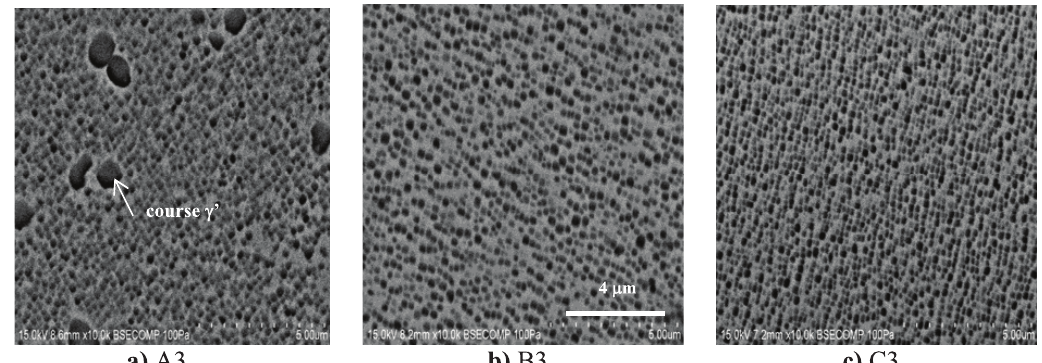
Figure 15. Microstructures of specimens after reheat treatment of Program 1.